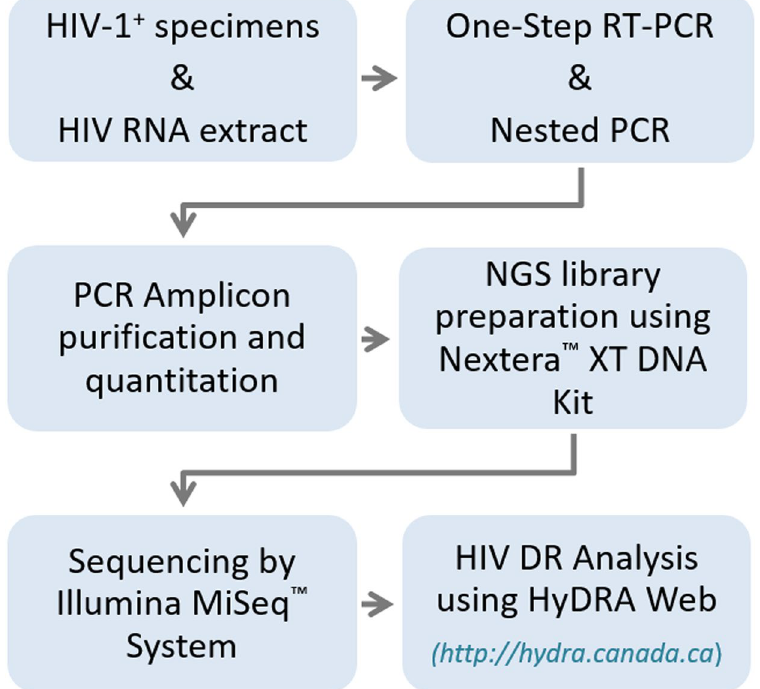
Figure 1. Miseq-HyDRA platform